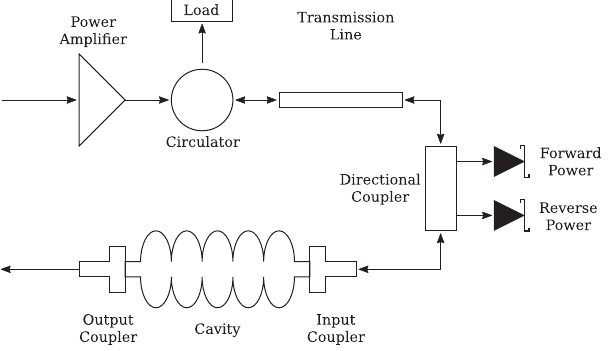
FIG. 5. Schematic of setup that was used for the rf power measurement during the ERL operation. A 40 dB attenuated forward and reverse rf signal was extracted by coaxial directional couplers and measured by Schottky diodes.